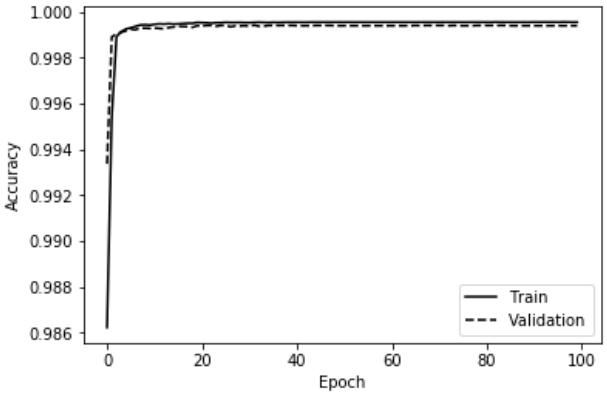
Figure 5. Deep ANN classifier (binary classification).